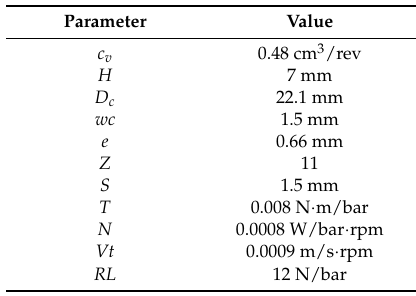
Table 1. Specifications of the mini trochoidal-gear